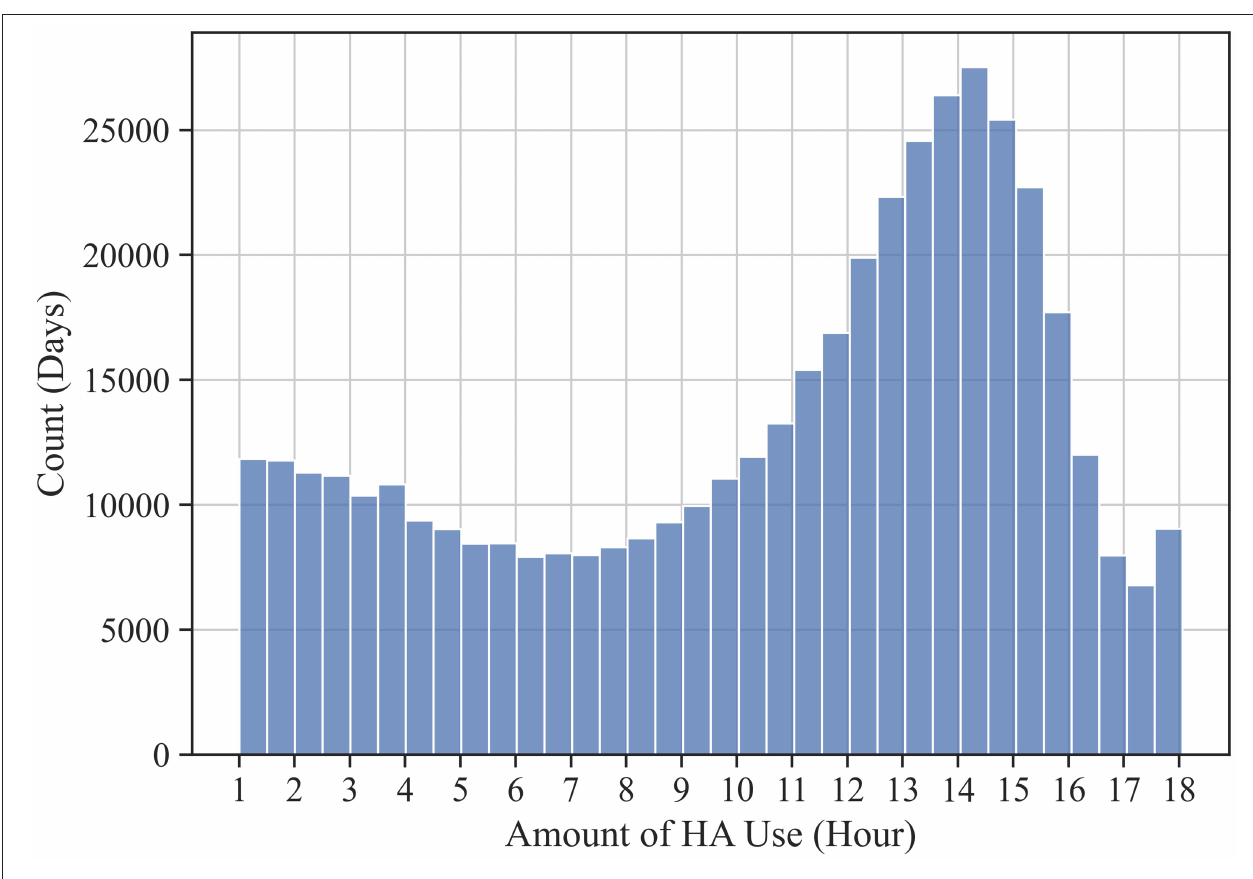
FIGURE 2 | Count of logged days by the amount of HA use time. Due to the data cleaning criteria (i.e., only days with at least 1h of HA use were included; only data related to HA use in the 18h between 6:00 and 23:59 were included), the amount of HA use (x-axis) ranges from 1 to 18h.